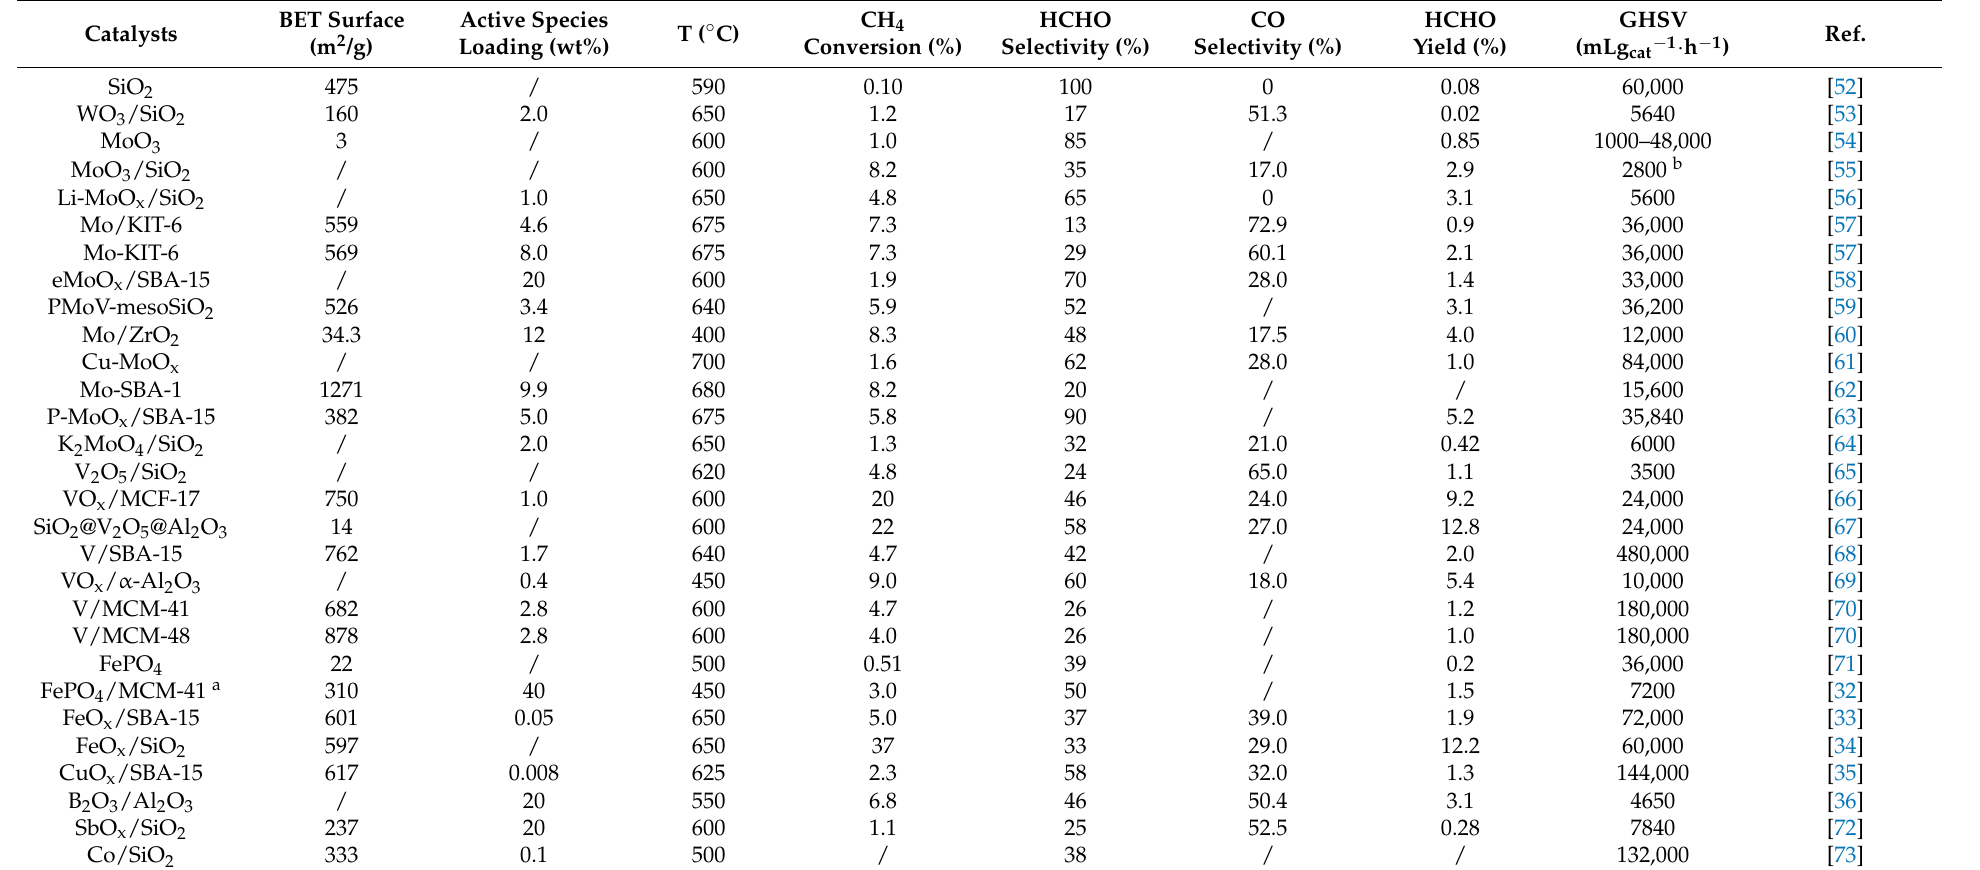
Table 1. Summary of catalysts and their catalytic activity for gas-phase partial oxidation of methane into